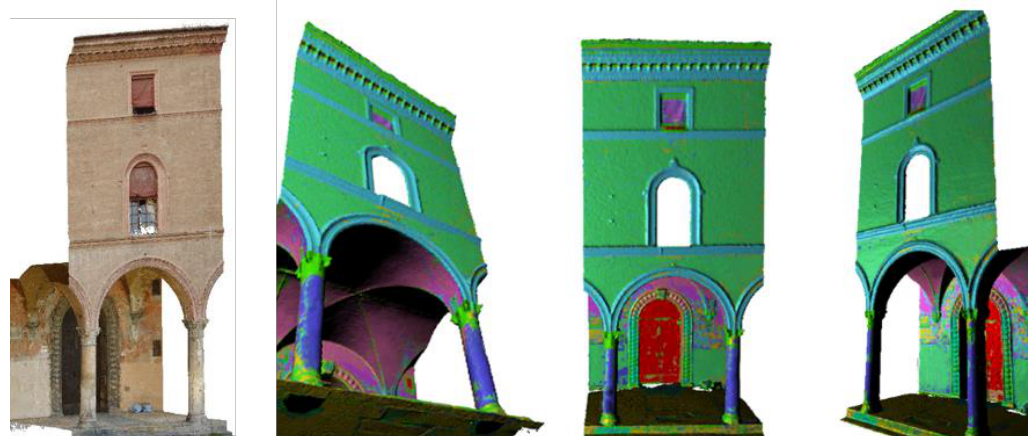
Figure 10: 3D model and classification results of an historical building in the city centre of